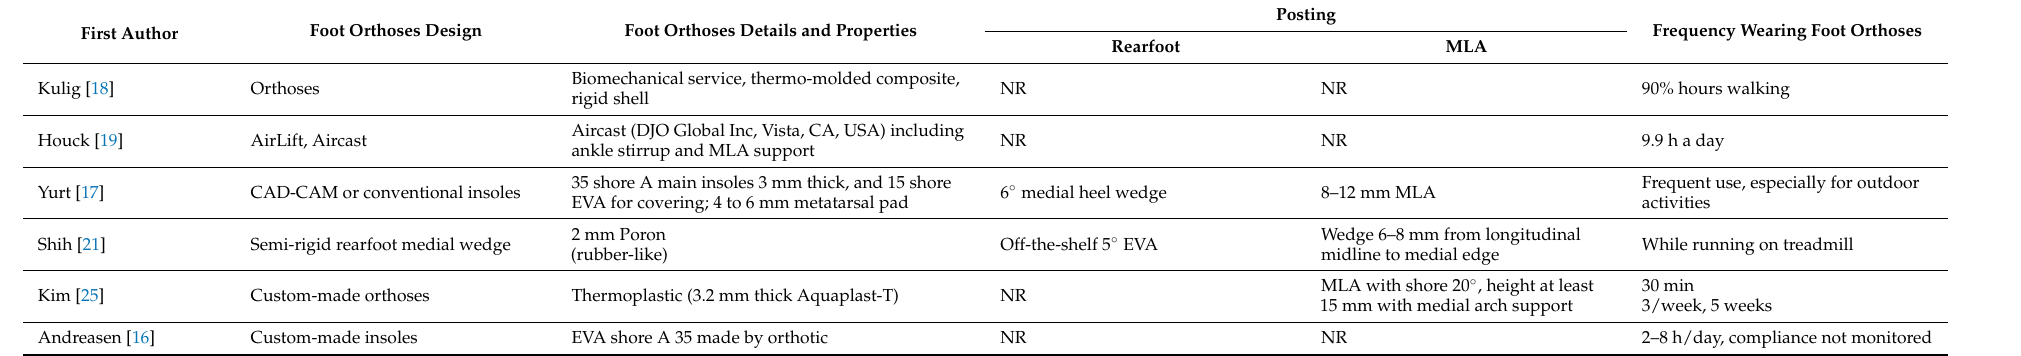
Table 4. Foot orthoses